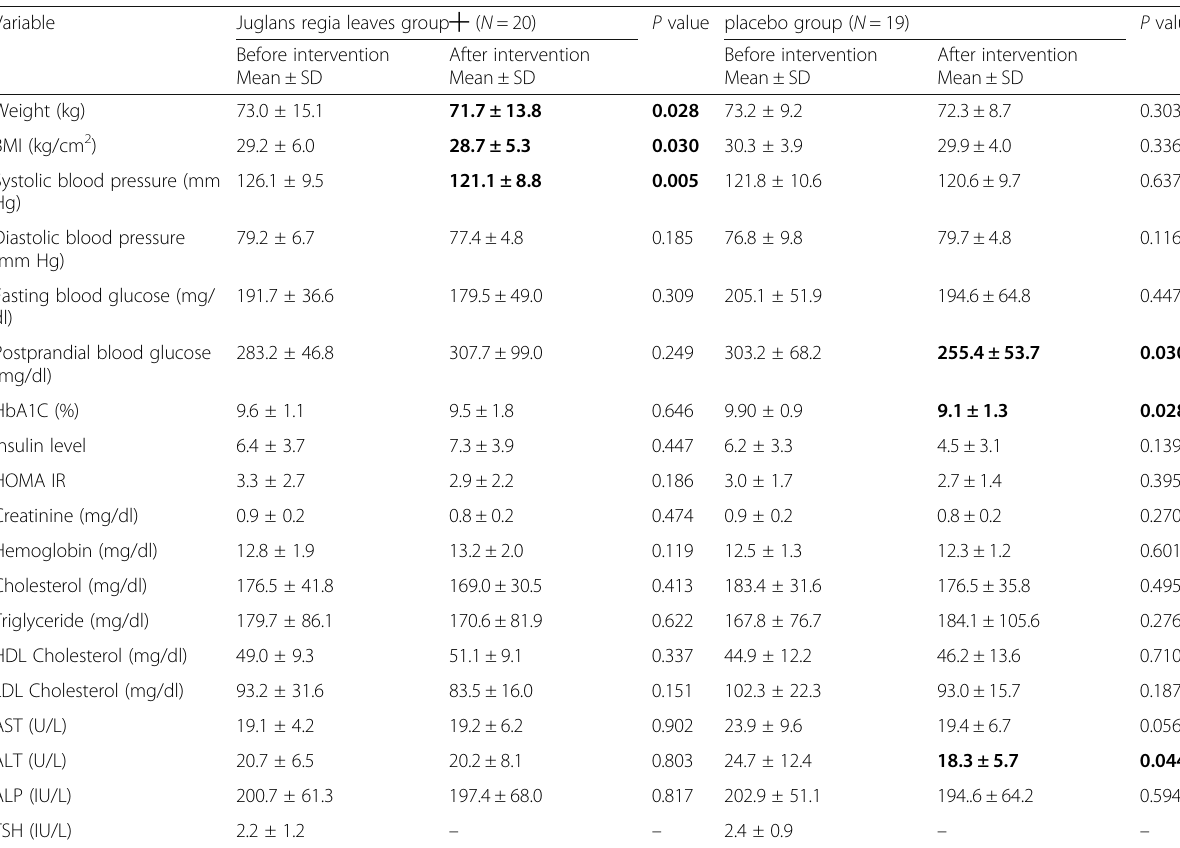
Table 2 Participant data before and after intervention in the case group (extract of Juglans regia leaves) and the placebo group